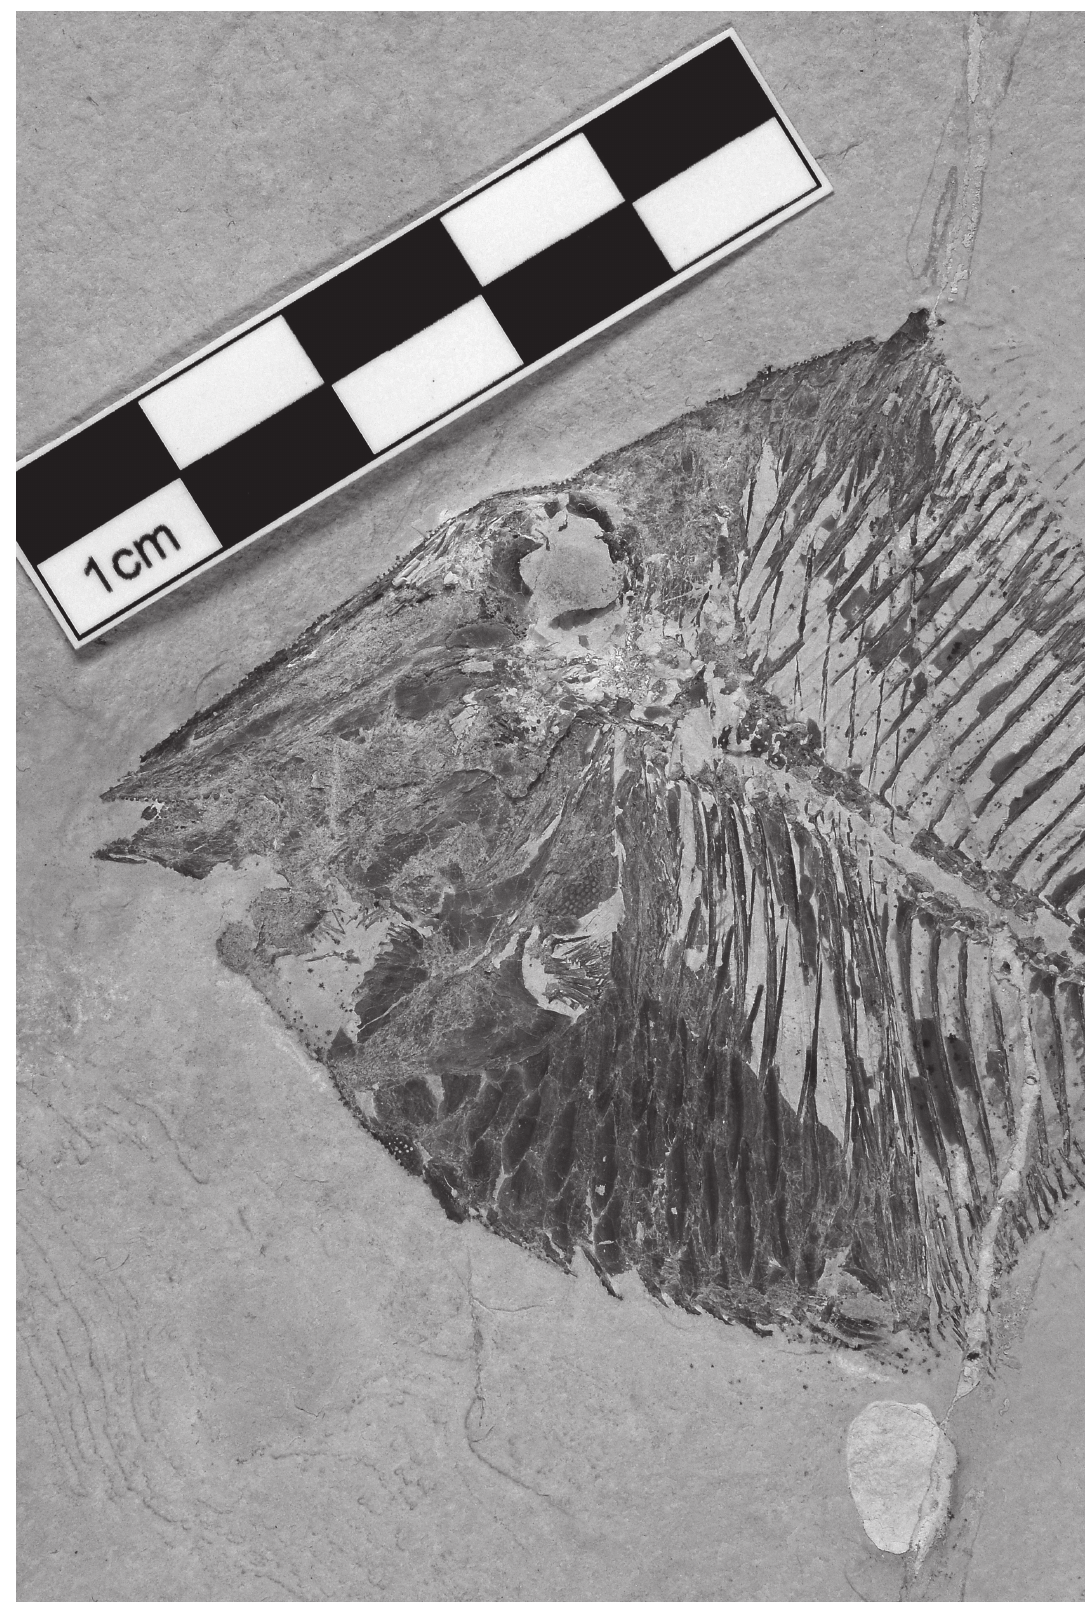
Fig. 7. Acrorhinichthys poyatoi gen. et sp. nov. Head and anterior region of the holotype CLC S-630b.